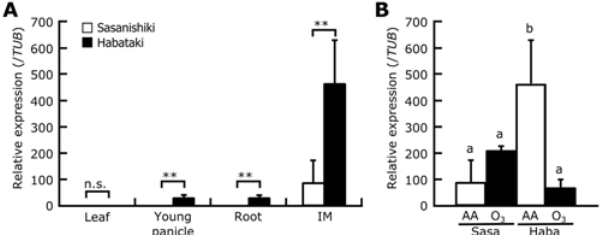
Fig 6. Relative levels of APO1 transcript in different organs. (A) APO1 transcript levels in the fourth leaf, young panicle (10 days before heading), root, and an inflorescence meristem (IM; 23 days before heading). (B) Ozone-induced changes in the APO1 transcript level in inflorescence meristems of Sasanishiki (Sasa) and Habataki (Haba). Values are mean ± SD ( n = 3). AA, ambient air; O 3 , elevated ozone. n.s., not significant; ** P < 0.05 (Student ’ s t -test, A). Bars topped by the same letters are not significantly different (Tukey ’ s HSD test, P < 0.05,